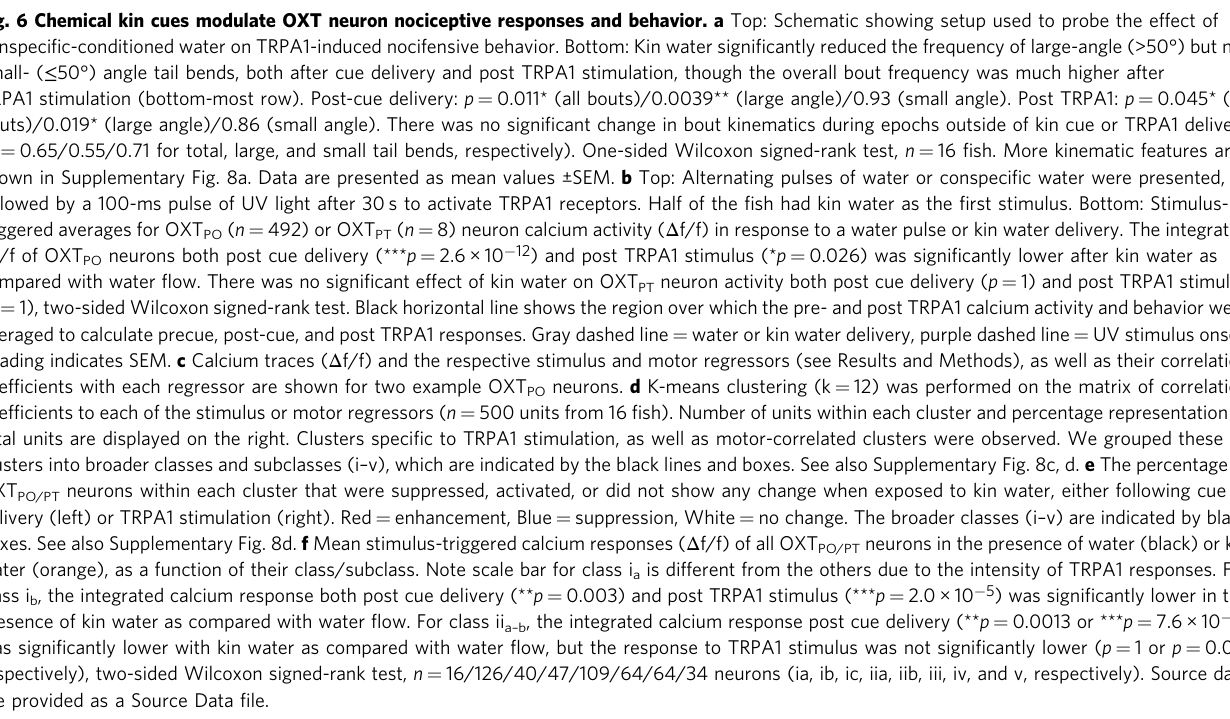
Fig. 6 Chemical kin cues modulate OXT neuron nociceptive responses and behavior. a Top: Schematic showing setup used to probe the effect of conspeci fi c-conditioned water on TRPA1-induced nocifensive behavior. Bottom: Kin water signi fi cantly reduced the frequency of large-angle (>50°) but not small- ( ≤ 50°) angle tail bends, both after cue delivery and post TRPA1 stimulation, though the overall bout frequency was much higher after TRPA1 stimulation (bottom-most row). Post-cue delivery: p = 0.011* (all bouts)/0.0039** (large angle)/0.93 (small angle). Post TRPA1: p = 0.045* (all bouts)/0.019* (large angle)/0.86 (small angle). There was no signi fi cant change in bout kinematics during epochs outside of kin cue or TRPA1 delivery ( p = 0.65/0.55/0.71 for total, large, and small tail bends, respectively). One-sided Wilcoxon signed-rank test, n = 16 fi sh. More kinematic features are shown in Supplementary Fig. 8a. Data are presented as mean values ±SEM. b Top: Alternating pulses of water or conspeci fi c water were presented, followed by a 100-ms pulse of UV light after 30 s to activate TRPA1 receptors. Half of the fi sh had kin water as the fi rst stimulus. Bottom: Stimulus- triggered averages for OXT PO ( n = 492) or OXT PT ( n = 8) neuron calcium activity ( Δ f/f) in response to a water pulse or kin water delivery. The integrated Δ f/f of OXT = 2.6 × 10 − 12 ) and post TRPA1 stimulus (* p = 0.026) was signi fi cantly lower after kin water as PO neurons both post cue delivery (*** p compared with water fl ow. There was no signi fi cant effect of kin water on OXT PT neuron activity both post cue delivery ( p = 1) and post TRPA1 stimulus ( p = 1), two-sided Wilcoxon signed-rank test. Black horizontal line shows the region over which the pre- and post TRPA1 calcium activity and behavior were averaged to calculate precue, post-cue, and post TRPA1 responses. Gray dashed line = water or kin water delivery, purple dashed line = UV stimulus onset, Shading indicates SEM. c Calcium traces ( Δ f/f) and the respective stimulus and motor regressors (see Results and Methods), as well as their correlation coef fi cients with each regressor are shown for two example OXT PO neurons. d K-means clustering (k = 12) was performed on the matrix of correlation coef fi cients to each of the stimulus or motor regressors ( n = 500 units from 16 fi sh). Number of units within each cluster and percentage representation of total units are displayed on the right. Clusters speci fi c to TRPA1 stimulation, as well as motor-correlated clusters were observed. We grouped these clusters into broader classes and subclasses (i – v), which are indicated by the black lines and boxes. See also Supplementary Fig. 8c, d. e The percentage of OXT PO/PT neurons within each cluster that were suppressed, activated, or did not show any change when exposed to kin water, either following cue delivery (left) or TRPA1 stimulation (right). Red = enhancement, Blue = suppression, White = no change. The broader classes (i – v) are indicated by black boxes. See also Supplementary Fig. 8d. f Mean stimulus-triggered calcium responses ( Δ f/f) of all OXT PO/PT neurons in the presence of water (black) or kin water (orange), as a function of their class/subclass. Note scale bar for class i a is different from the others due to the intensity of TRPA1 responses. For class i b , the integrated calcium response both post cue delivery (** p = 0.003) and post TRPA1 stimulus (*** p = 2.0 × 10 − 5 ) was signi fi cantly lower in the presence of kin water as compared with water fl ow. For class ii a – b , the integrated calcium response post cue delivery (** p = 0.0013 or *** p = 7.6 × 10 − 7 ) was signi fi cantly lower with kin water as compared with water fl ow, but the response to TRPA1 stimulus was not signi fi cantly lower ( p = 1 or p = 0.06, respectively), two-sided Wilcoxon signed-rank test, n = 16/126/40/47/109/64/64/34 neurons (ia, ib, ic, iia, iib, iii, iv, and v, respectively). Source data are provided as a Source Data fi